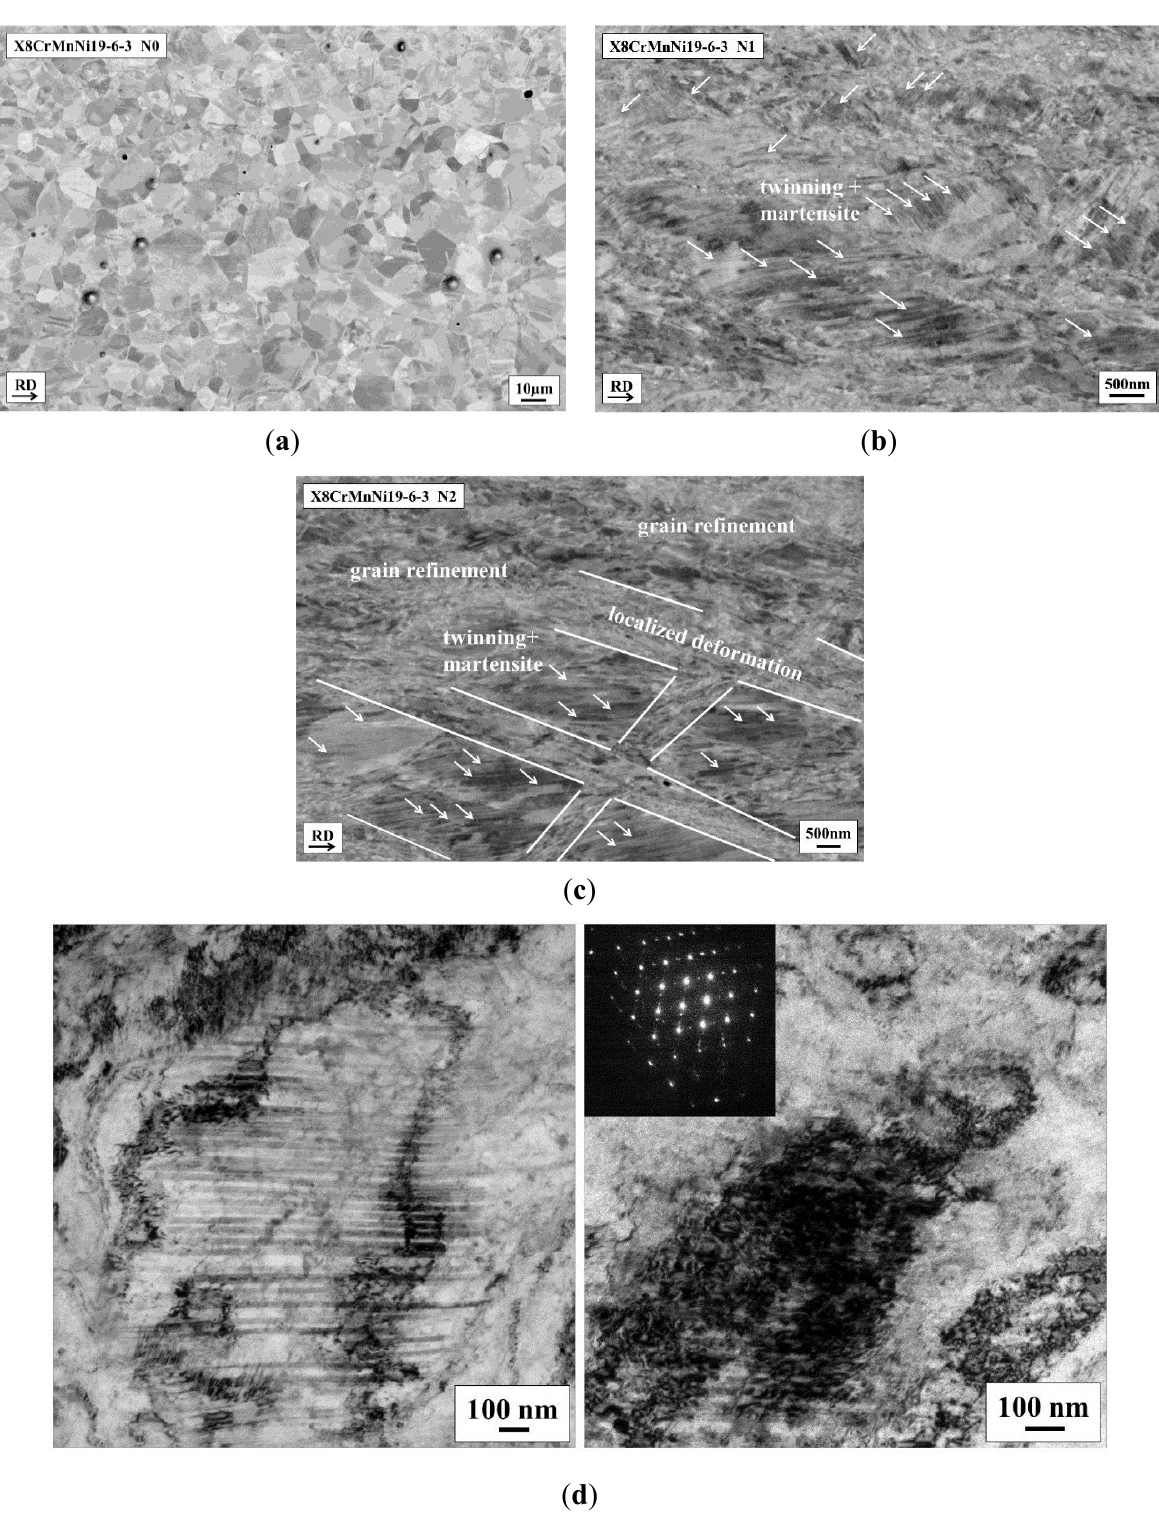
Figure 5. SEM micrographs of ARB-processed austenitic steel X8CrMnNi19-6-3 after ( a ) N0, ( b ) N1 and ( c ) N2 cycles. The arrows indicate areas where twins but also martensite was found. ( d ) TEM bright-field caption after N2 ARB-cycles and the corresponding diffraction pattern of this